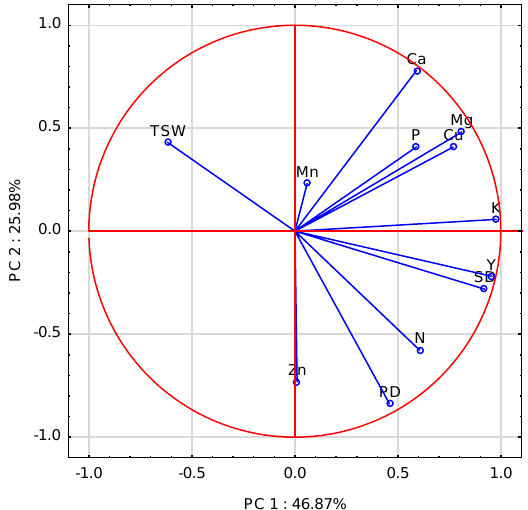
Figure 3. Score plot of WOSR components and nutrients accumulated in WOSR post-harvest residues in PC1 and PC2 axes. Y—Yield, SD—Seed Density, PD—Pod Density, TSW—Thousand Seed Weight, N, P, K, Mg, Ca, Mn, Zn,